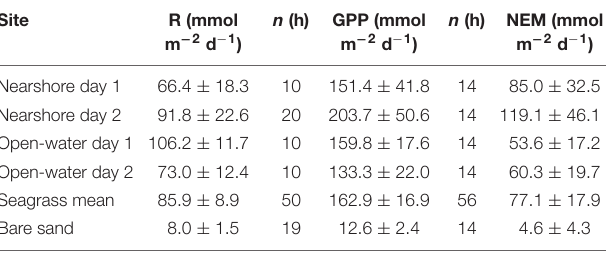
TABLE 2 | Community metabolic fluxes including respiration (R), gross primary production (GPP), and net ecosystem metabolism (NEM; ± standard